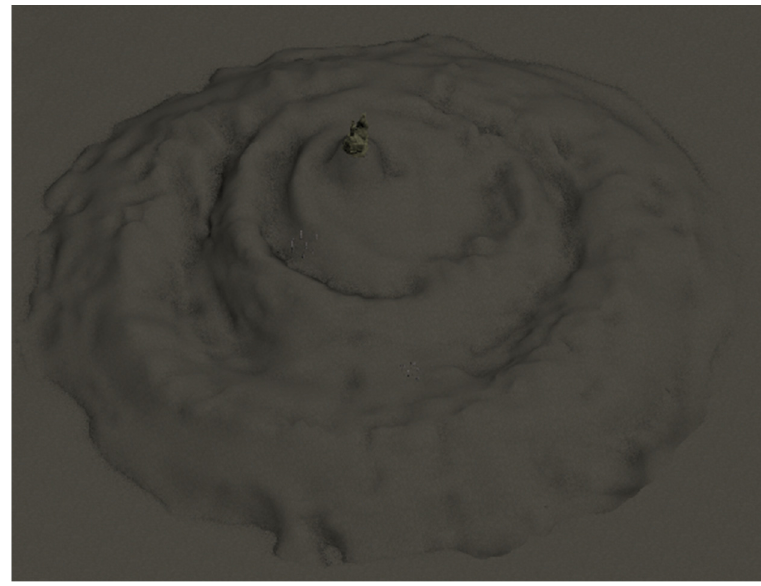
Figure 4. The built TAG hydrothermal mound.